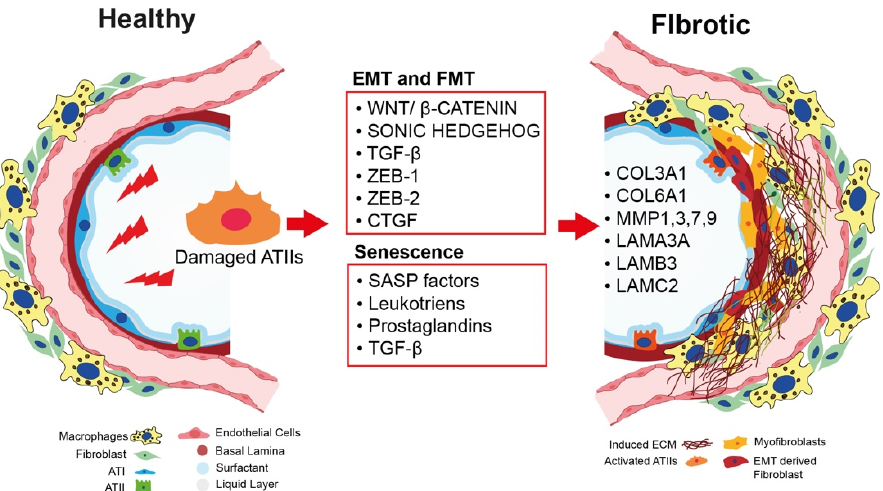
Figure 2. Key processes inducing pulmonary fibrosis. Repetitive injuries in human adult lung lead to damaged ATII cells (orange). Damaged ATII cells begin overexpressing the Wnt/ β -catenin and SHH signaling pathways and secreting TGF- β . They also start expressing ZEB-1, ZEB-2, and CTGF as a response to TGF- β secretion. These factors are involved in the EMT and FMT processes. In parallel, damaged ATII cells acquire a senescent phenotype, producing SASP factors, leukotrienes, and prostaglandins. These factors collectively contribute to the proliferation of myofibroblasts which, in turn, are responsible for the aberrant deposition of ECM components, such as COL3A1, COL6A1, MMP1, MMP3, MMP7, MMP9, LAMA3, LAMB3, and LAMC2.